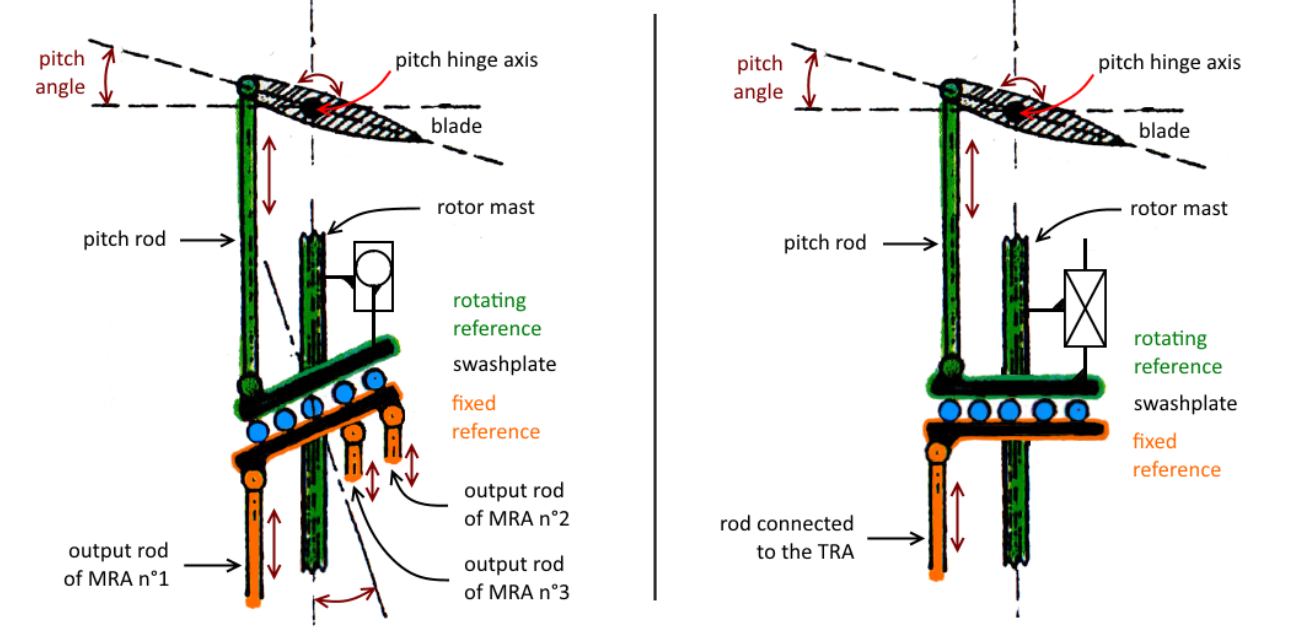
Figure 5. Sketch of principle of the main rotor ( left ) and the tail rotor ( right ) on helicopters. The main rotor is responsible for lifting the helicopter weight. The tail rotor ensures the control of the helicopter yaw